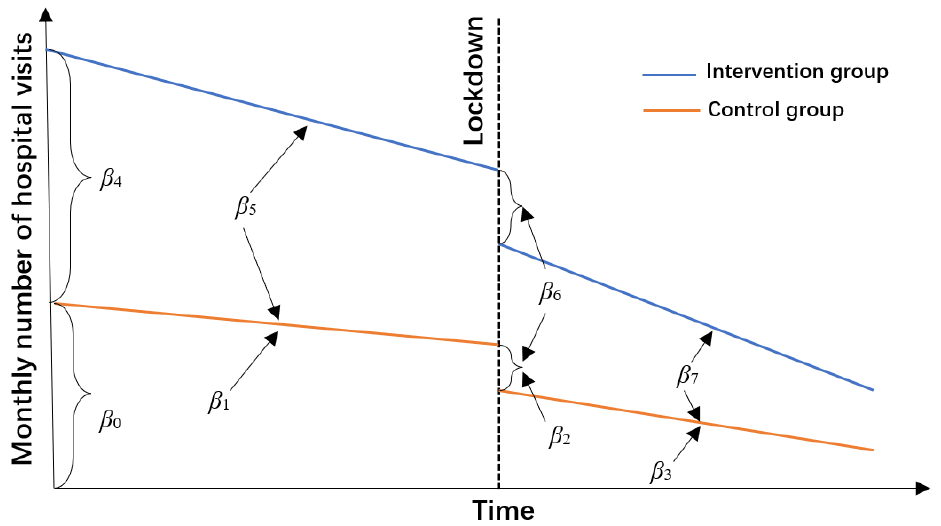
Figure 1. The segmented regression model for a controlled interrupted time series analysis. We used negative binomial regressions to test the trend in monthly hospital visits after the COVID-19 lockdown policy because we confirmed the over-dispersion of data using the likelihood ratio tests, which violated the assumption of Poisson regression [39]. To adjust for autocorrelation and heteroscedasticity of residuals, we used the Newey–West method [40] to estimate standard errors. We also included monthly indicator variables as covariates to adjust for observed seasonal patterns [37]. All statistical analyses were performed using R (version 4.0.2). All tests were two-tailed, and statistical significance was defined as p <